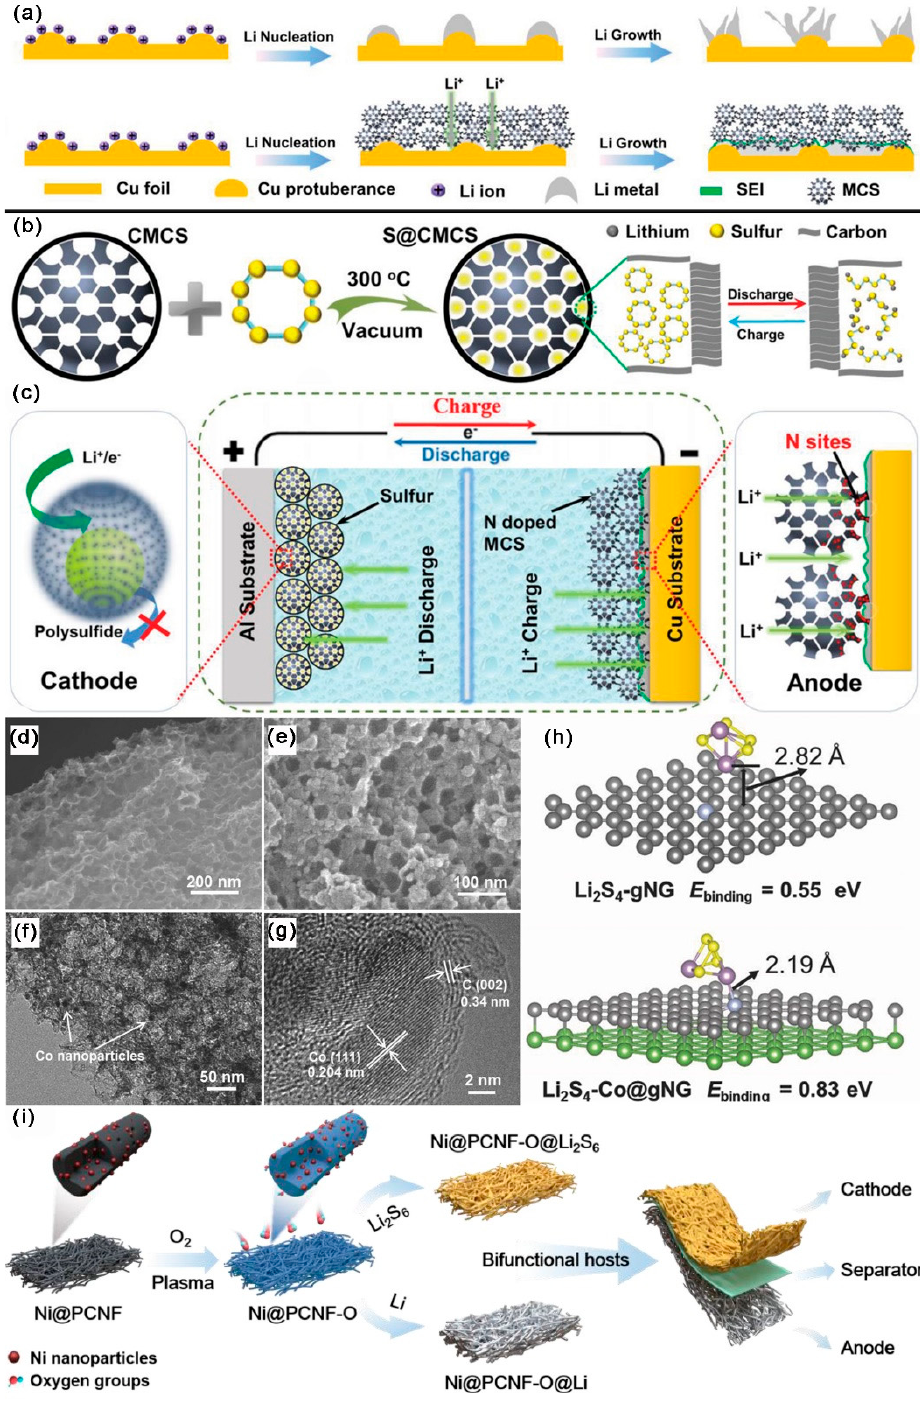
Figure 21. ( a ) Schematic diagram of Li growing on Cu foil optimized by MCS900. ( b ) Schematic diagram of the mechanisms of Ni@PCNF-O@Li 2 S 6 during the battery operation process. ( c ) Schematic diagram of S@CMCS1100||Li@MCS900 batteries [150]. ( d , e ) SEM and ( f , g ) TEM images of Co/N- PCNSs; ( h ) Li 2 S 4 and Co@gNG’s (the doped graphene with the introduction of graphitic N) binding energy was calculated using DFT (yellow: S, purple: Li, grey: C, green: Co) [151]. ( i ) Schematic diagram of the synthesis of Ni@PCNF-O@Li 2 S 6 and Ni@PCNF-O@Li